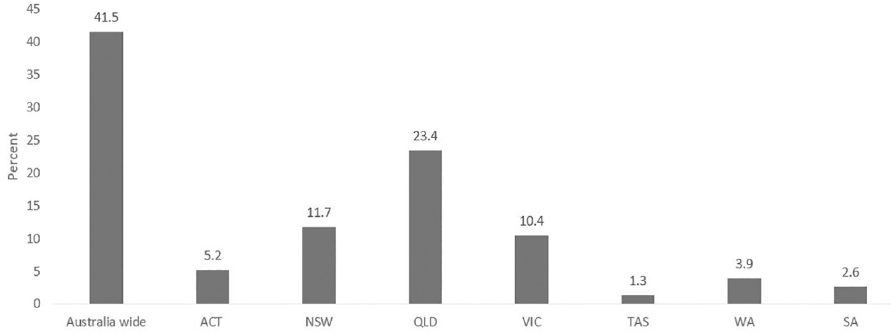
Fig 2. Distribution of research-based articles based on the location of